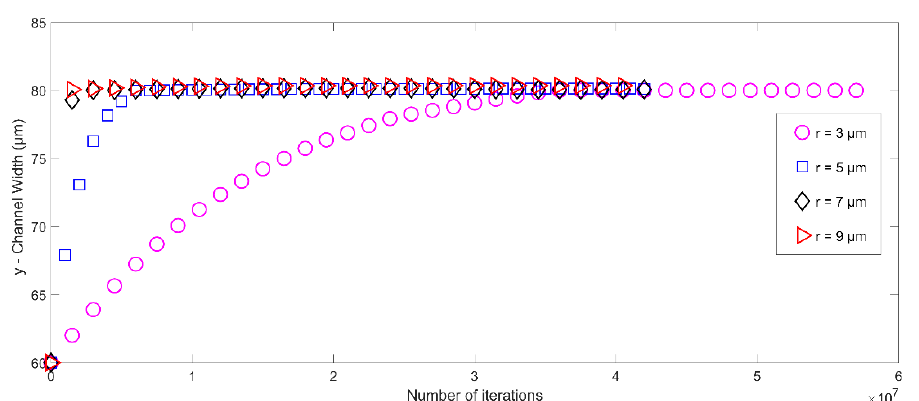
Figure 8. The trajectory of different-sized microparticles subjected to acoustic radiation force in microchannel as a function of time and initial position.